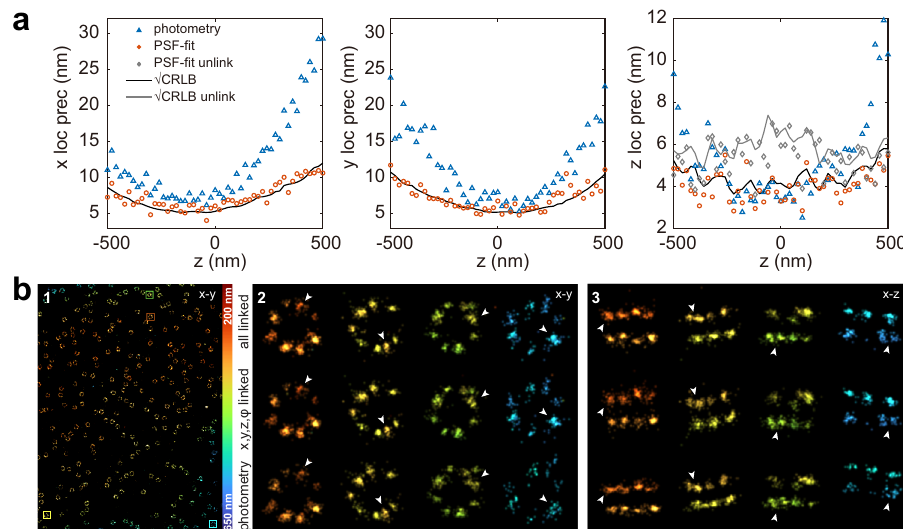
Fig. 3 Performance of globLoc on 4Pi-SMLM data. a Localization precision for 4Pi-SMLM imaging of fl uorescent beads. A single 40 nm red fl uorescence bead (F8793, Invitrogen) was imaged at z positions from − 500 nm to 500 nm with 20 nm step size and 37 frames were collected at each z position. The estimated photons/objective is 464 ± 40 (mean ± s.t.d) and the background photons/pixel is 0.47 ± 0.04 (mean ± s.t.d). The localization precision is ffiffiffiffiffiffiffiffiffiffiffi p calculated as the standard deviation. Theoretical estimated precision ( CRLB ) in z increases when unlinking the photon and background in four phase channels. b Comparison of globLoc on 4Pi-SMLM data under different parameter sharing schemes and compared to the state-of-the art analysis (photometry) 11 , on the example of Nup96-AF647. b2 – 3 Top-view and side-view reconstructions of selected NPCs at different z positions as indicated in b1 (all linked: globLoc with x , y , z , photons and background photons linked; x,y,z , φ linked: globLoc with x , y and z and the phase linked). Representative results are shown from 3 experiments for ( b ). Scale bars 10 µ m 1 µ m (b1), 100 nm